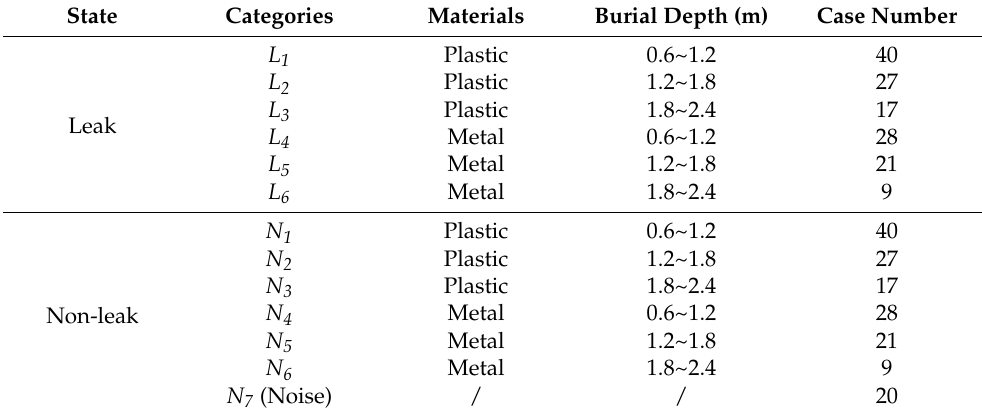
Table 3. The signals collected in the actual